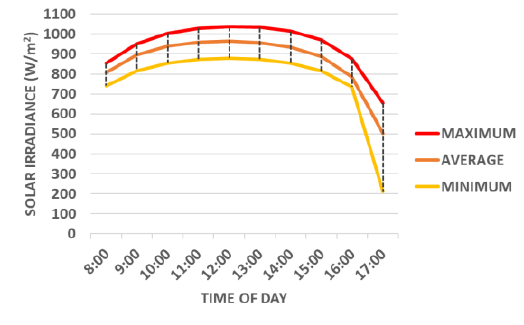
Figure 12. Hourly Solar Irradiation (2017)